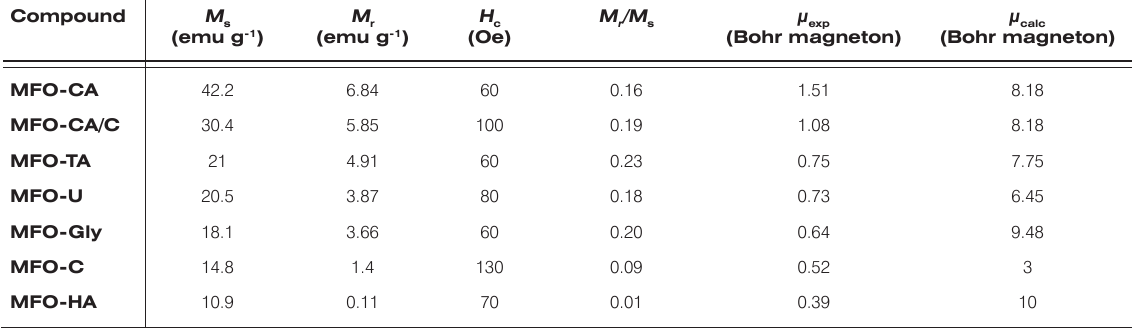
O powders heat treated at 1173 K. 2 4